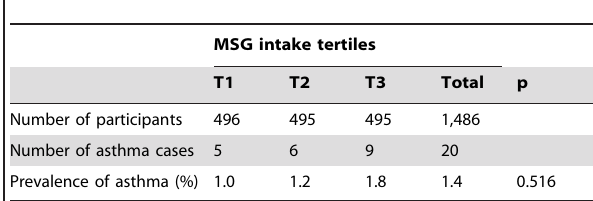
Table 2. Prevalence of asthma by tertiles of monosodium glutamate (MSG) intake tertiles among adults in China (Jiangsu Nutrition Study) (n=